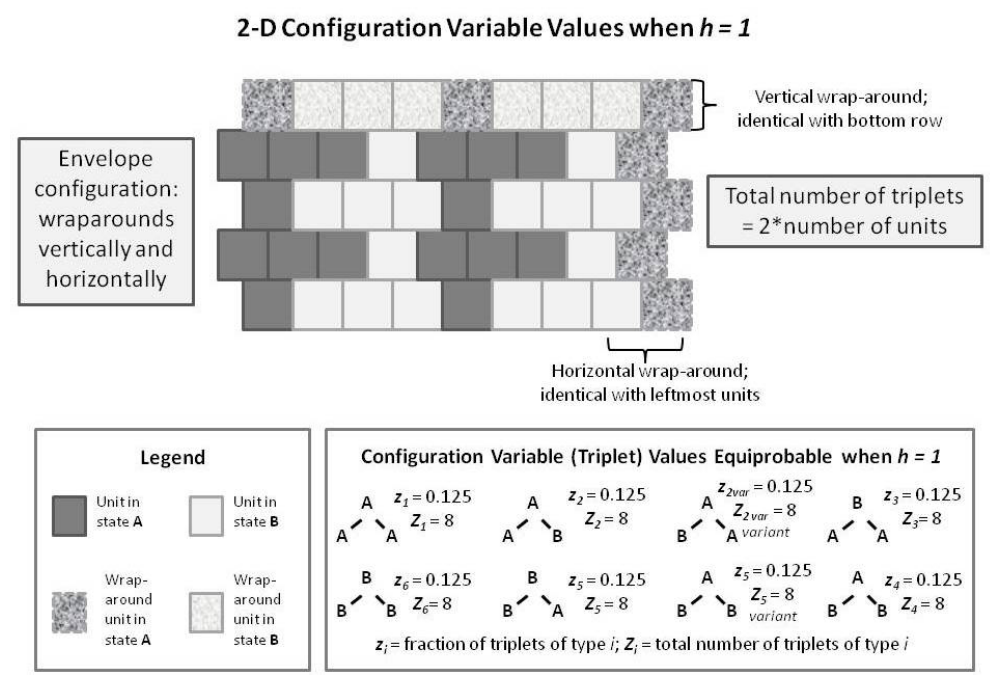
Figure 8. A 2-D CVM configuration (built by superimposing two single zigzag chains), together with both the total numbers and fractional amounts for the configuration variables z i . Note that the wraparound in this case forms a full envelope; the configuration variables are computed in a smooth manner, wrapping both horizontally and vertically. The total number of triplets is equal to two times the total number of units in the